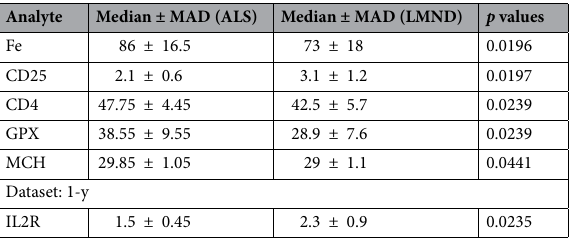
(associated with a reduced amount of Tran), and higher values of CK (associated with lower values of LA) than LMND. From the inflammatory-immunological analyte group, ALS patients had a lower amount of alpha- and beta-globulin, but a higher number of gamma-globulins as well as IgG, IgA, IgM, and IgE content. Other relevant immunological biomarkers were found significantly different between the two patients’ groups: ALS showed higher amounts of CD3 and CD4, IL3, IL8, and lower levels of CD19 lymphocytes, soluble IL2R, soluble IL6R, TNF, TNFRs, and IL12 (Table 2). hSc and 1-y datasets. When we consider only the subset of patients with high ALSFRSR (i.e., hSc group), we note that ALS patients had average lower values of Tran and higher levels of iron than LMND ones. Moreover, also in this case, several immunological biomarkers were found significantly different between the two patients’ groups (see Table 2): results revealed a higher percentage of CD4 cells and IL3 as well as a significantly lower percentage of CD8 and CD25 cells in the hSc -ALS group. Focusing on the 1-y dataset, 1-y -LMND patients had a significantly higher level of soluble IL2R than 1-y -ALS patients. ALS versus LMND classification results.